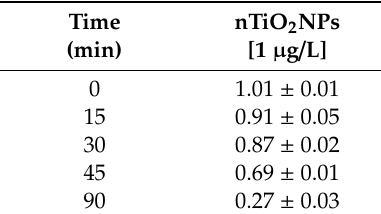
Table 1. Dispersion of tested 1 μg/L TiO 2 NPs-enriched culture media at 0, 15, 30, 45 and 90 min calculated on the TiO 2 NPs calibration curve, obtained by plotting the absorbance at the maximum wavelength (325 nm) vs. the different sonicated standard solutions’ dose levels.